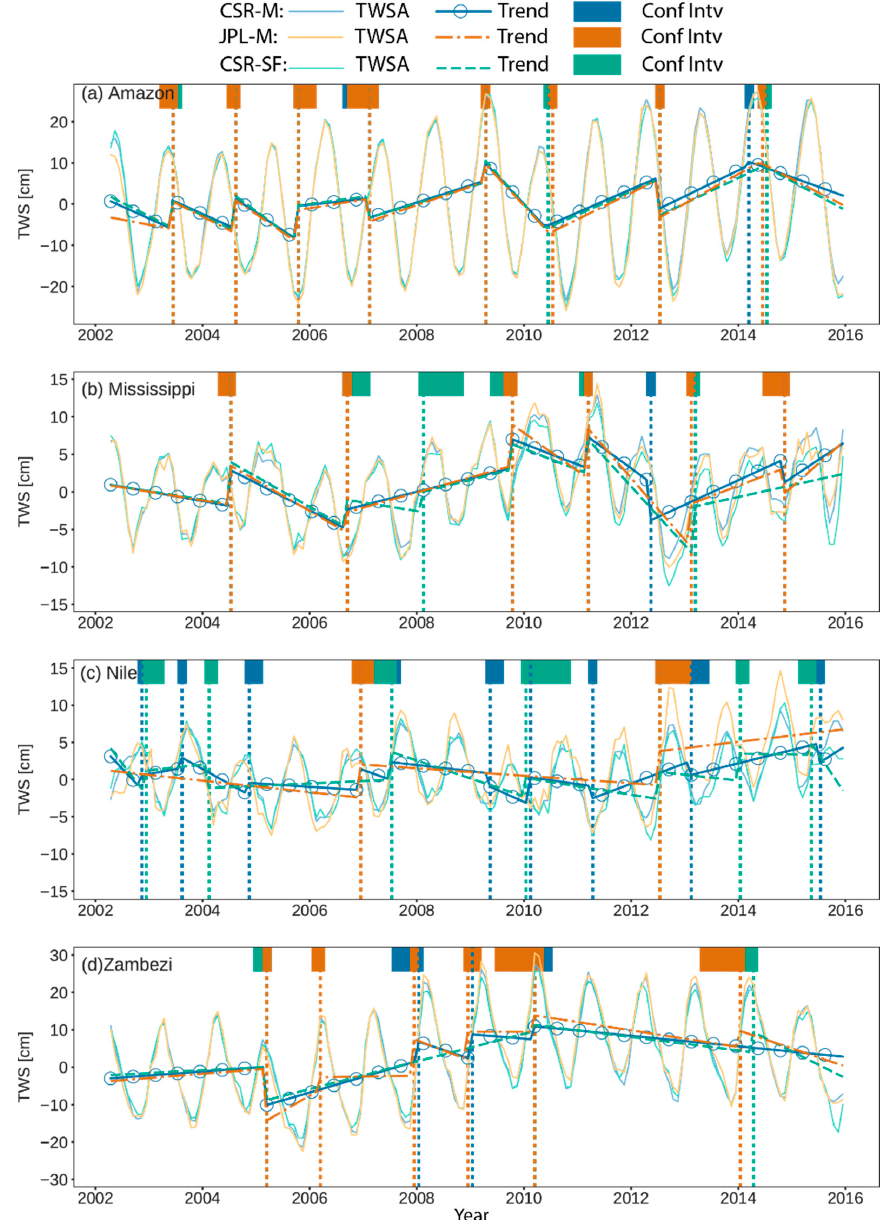
Figure 7. Comparison of BPs detected using 3 different GRACE products, CSR-M (blue with open circles), scaled CSR gridded SH (CSR-SF) (brown), and JPL mascon (JPL-M) (green) for ( a ) Amazon, ( b ) Mississippi, ( c ) Nile, and ( d ) Zambezi river basins. BPs (vertical dashed lines) detected by CSR-M and JPL-M are similar, while those by CSR-SF show noticeable discrepancies.